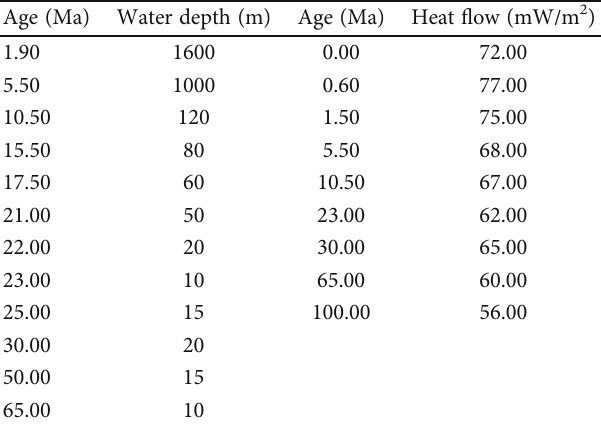
Table 2: The parameters of the paleo-heat fl ow and paleo-water depth in the study area